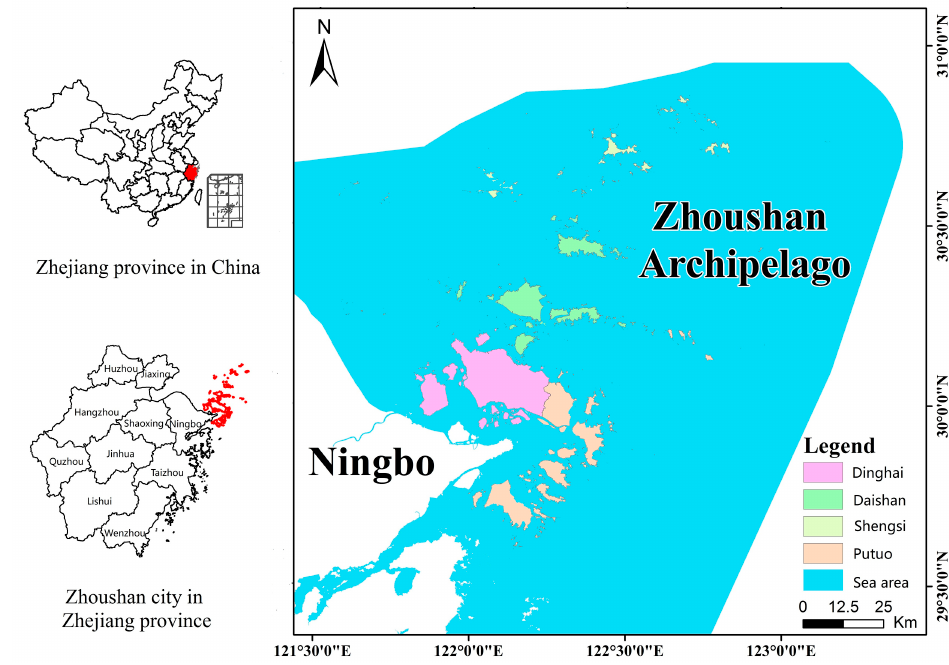
Figure 1. The location of Zhoushan Archipelago.